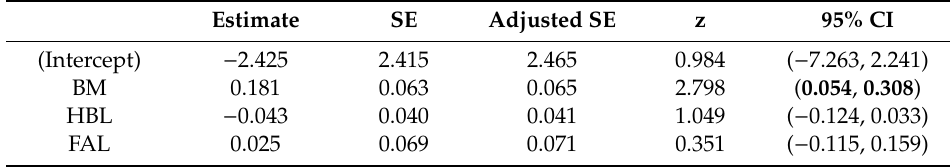
Table 4. Model-averaged parameter estimates of the best-supported (before and including the null model) linear mixed models describing activity variation with body size in female Asian particolored